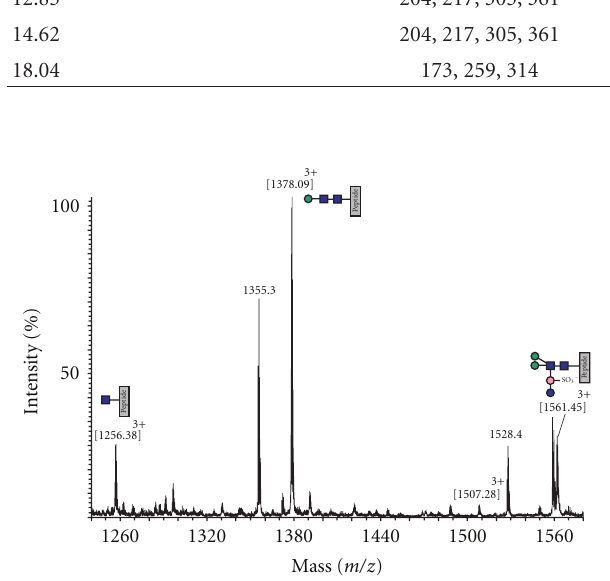
Figure 6: Summed mass spectra of T24 recorded between 48.5 and 50.6 min from an on-line nanoLC-ES-MS/MS analysis of an in-gel tryptic digest of the S-layer. The triply charged signals at m/z 1256.38, 1378.09, 1507.28, and 1561.45 are molecular ions of glycopeptides of sequence LLNLNVQQLNNSILSVTYHDYVT- GETLTATTK carrying the glycans shown in the annotations. Unassigned signals are molecular ions of peptides from elsewhere in the